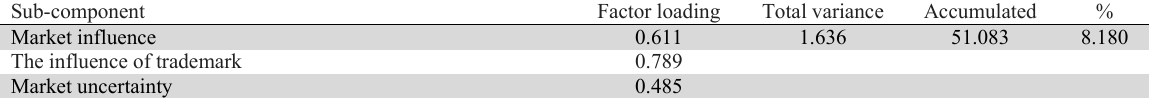
The summary of the sub-component influencing on details of content marketing Sub-component Factor loading